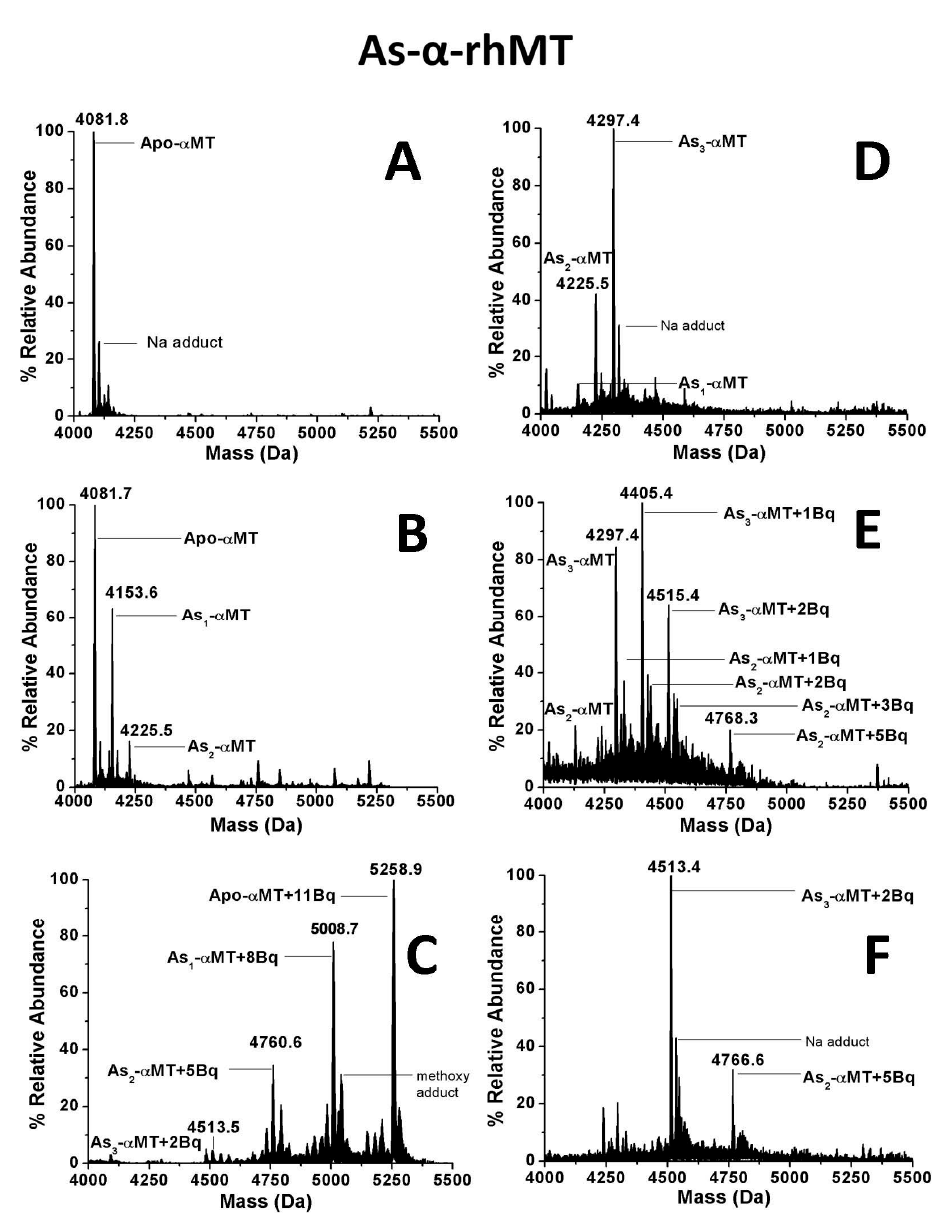
Figure 2. Deconvoluted electrospray ionization mass spectra (ESI-MS) of Arsenic-MT species (As 0-3 - α -MT-1a) covalently modified by p -benzoquinone (Bq). ( A ) Metal-free protein; ( B ) Partially metalated α -MT with As(III) with a large fraction of apo-protein; ( C ) Species in 1B fully modified by excess Bq; ( D ) Partially metalated α -MT with a larger fraction of saturated As 3 - α -MT; ( E ) Addition of 2 mol eq. of Bq to the species in 1D; ( F ) Species in 1D fully modified by excess Bq. Reproduced with permission from Irvine et al., 2013 [87].